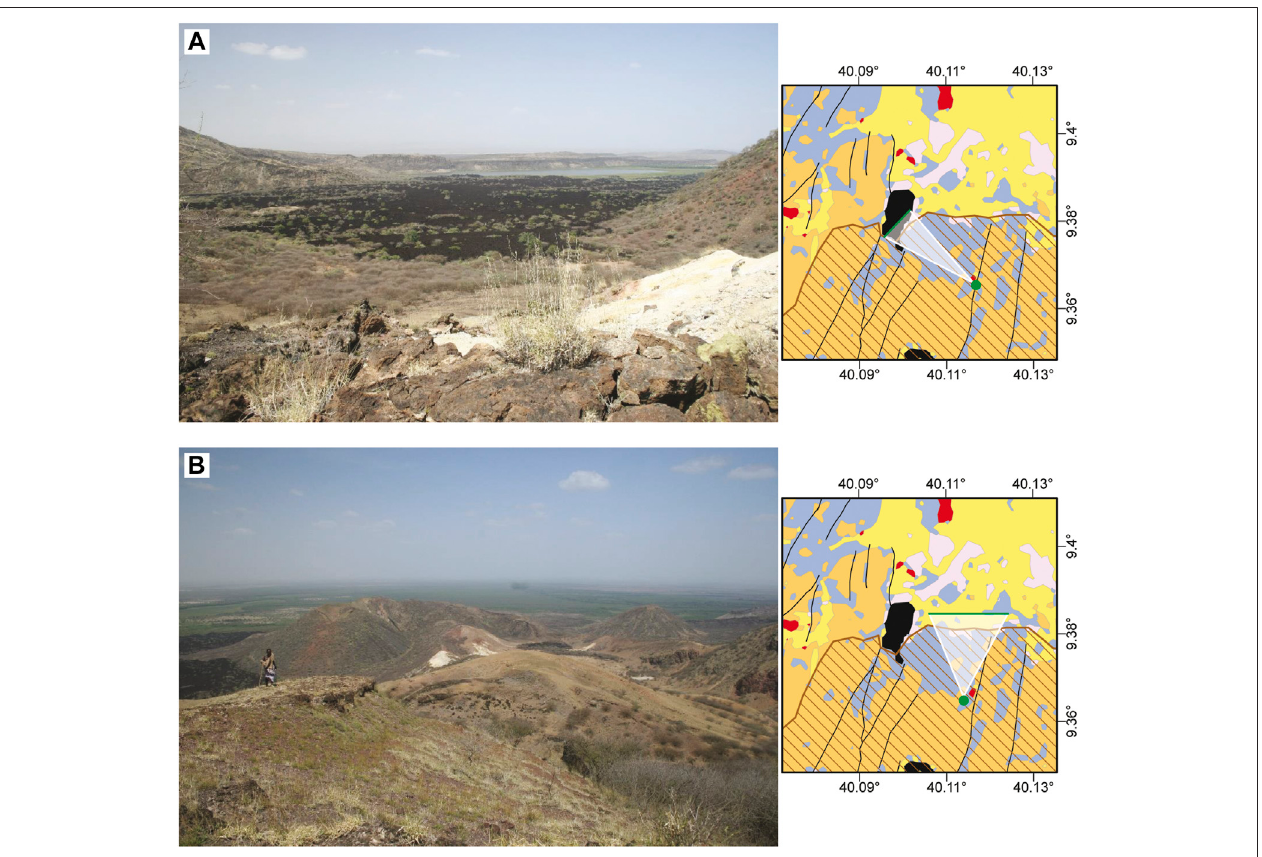
FIGURE4| PhotostakenattheDVCbyJulieRoland.Inthelocationmapsontherightsidethelocationfromwherethephotosweretakenisshown(greendot)and the correspondent horizons (green lines) in photos. (A) Was taken near the in proximity of hydrothermal alterations (red inmap and white in photo) that appear close-up whileinthebackgroundtheyoungbasalts(blueinmapandblackinphoto)arevisible. (B) Wastakenfromamoresoutherlypoint,anditreportsontheleftsidetheyoung basalts (blue in map and black in photo), on central part the hydrothermal alterations (red in map and white in photo) and on the background the rift valley.